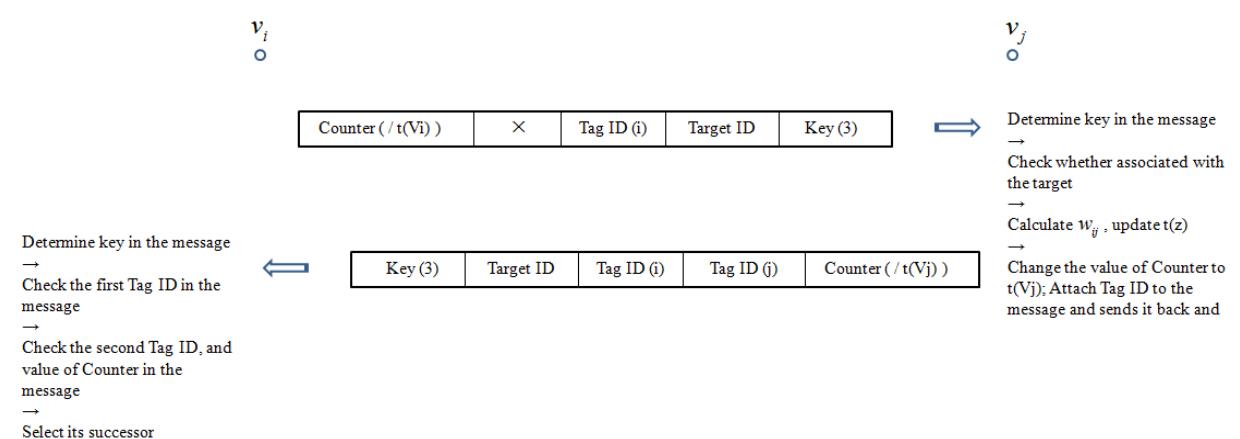
Figure 14. Channel quality sensing process between two RFID tag